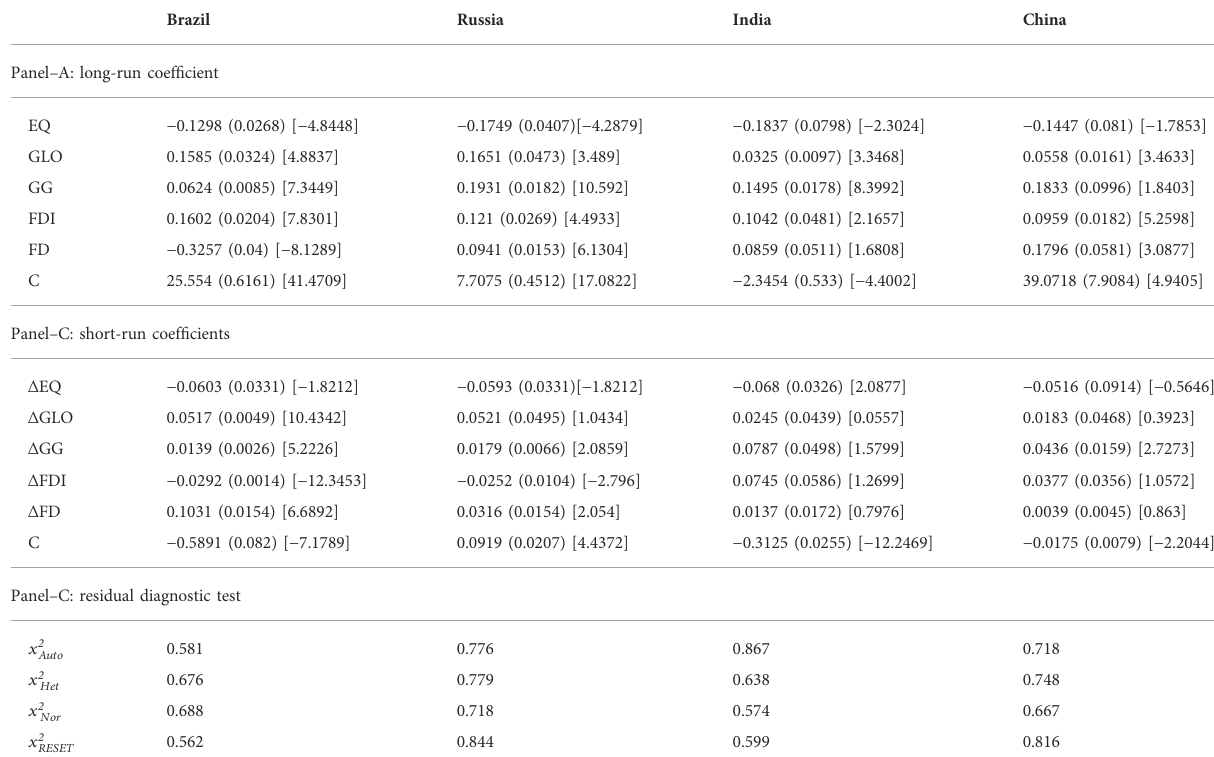
TABLE 6 Long-run and short-run coef fi cients: ARDL